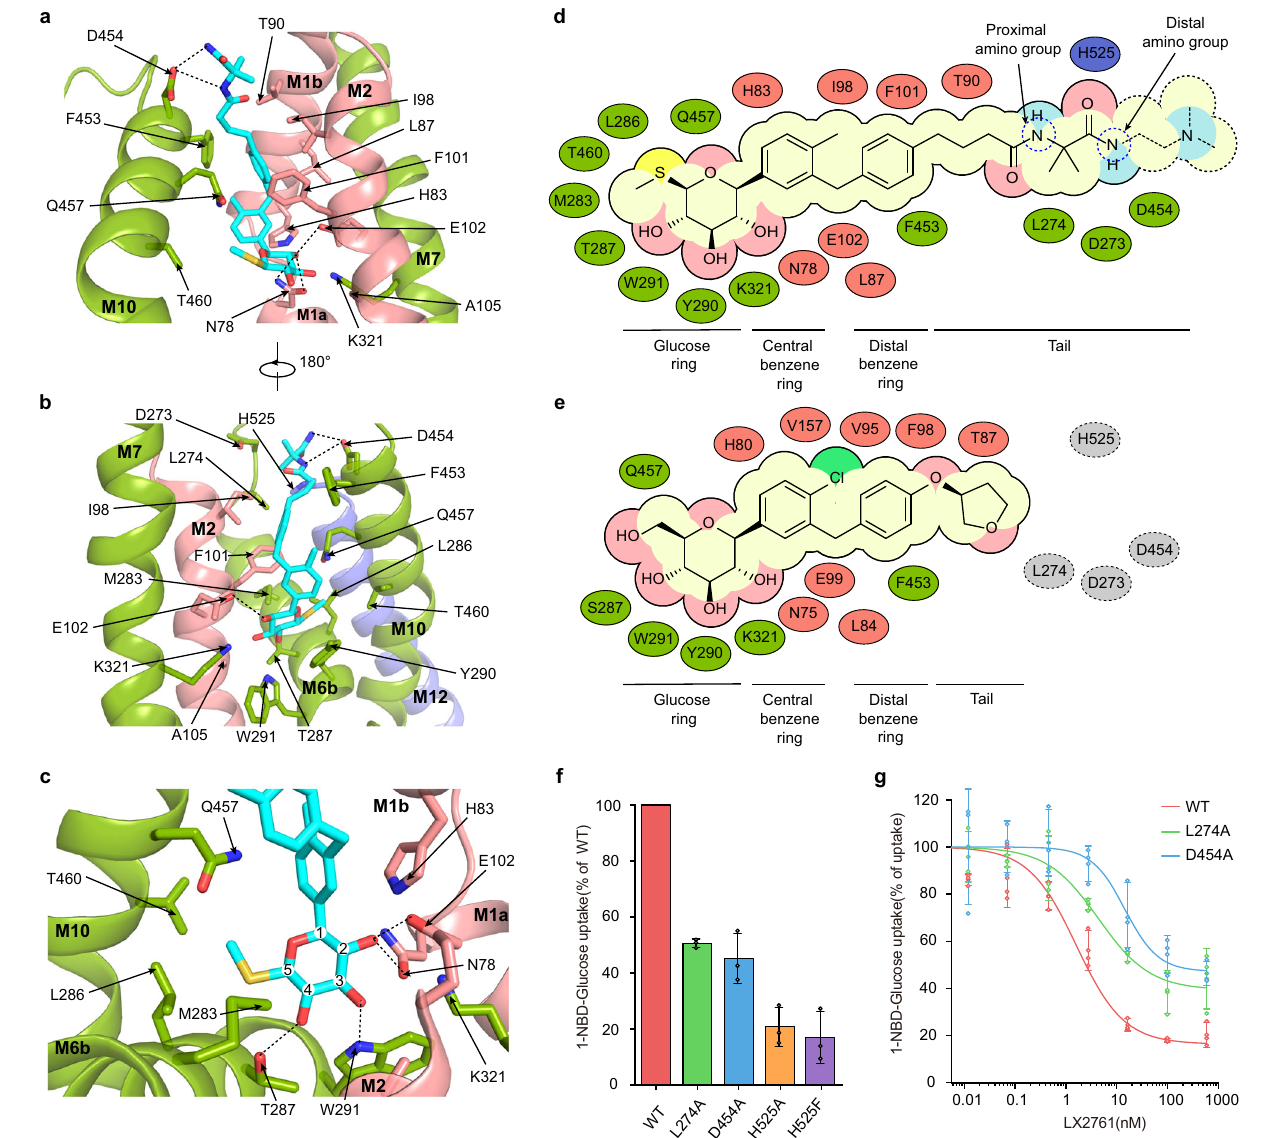
Fig.2|TheLX2761bindingsiteofhSGLT1.a Theclose-upviewofLX2761binding pocket of hSGLT1. LX2761 and binding-site residues are shown as sticks. Putative hydrogen bonds are indicated as black dashed lines. b A 180° rotated view of a . c Interactions between hydroxyl groups of LX2761 and hSGLT1. Putative hydrogen bonds are depicted as black dashed lines. d Cartoon representation of the inter- actions between LX2761 and hSGLT1. e Cartoon representation of the interactions between empagli fl ozin and hSGLT2. The residues of hSGLT2 that might